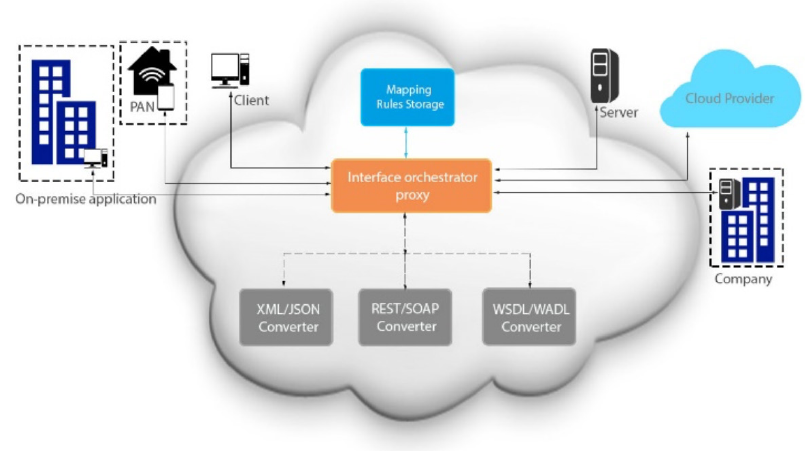
Fig. 1. Global Architecture of